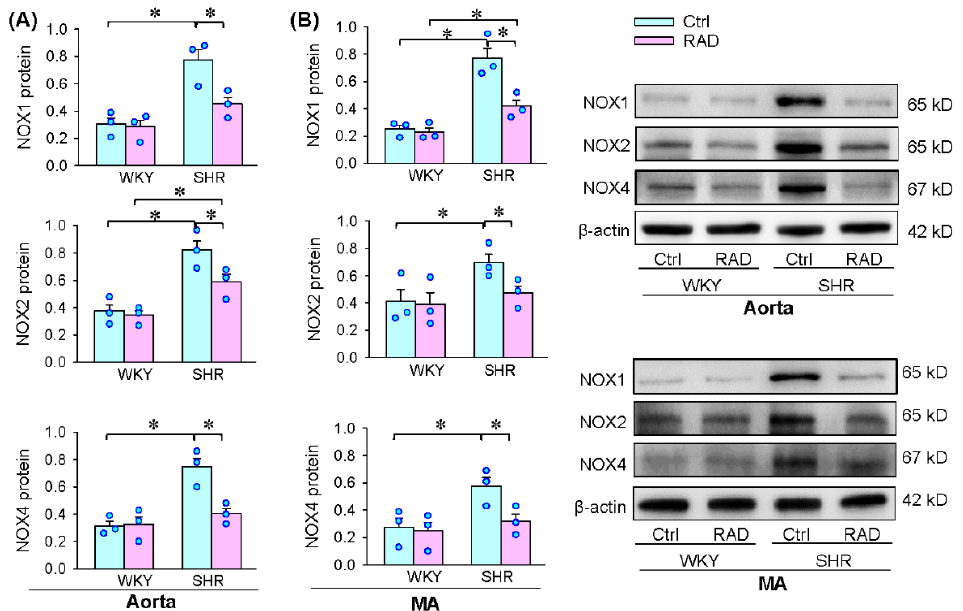
Figure 7. Effects of RAD on NOX protein expressions in the aorta and mesenteric artery (MA) of WKY and SHR. ( A ) NOX1, NOX2 and NOX4 protein expressions in the aorta. ( B ) NOX1, NOX2 and NOX4 protein expressions in the MA. Values are mean ± SE. Two-way ANOVA followed by Bonferroni’s post hoc analysis were used for comparisons. * p < 0.05. n = 3 for each group.